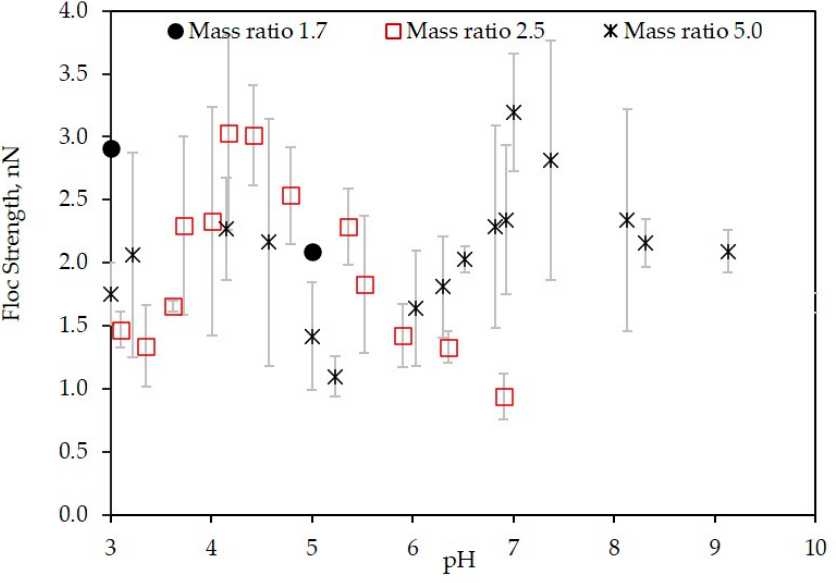
Figure 7. Floc strength of the LSZ–LHA complex at a different mass ratio (1.7, 2.5, and 5) in 10 mM KCl concentration as a function of pH.